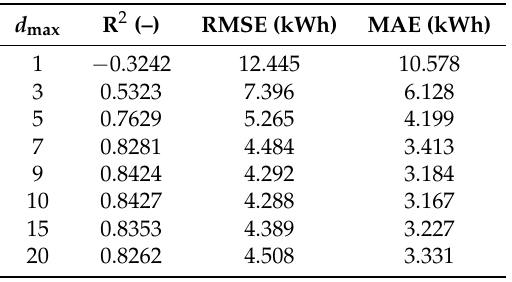
Table 9. Results of different d max , where n min = 3, K = 4 and M =